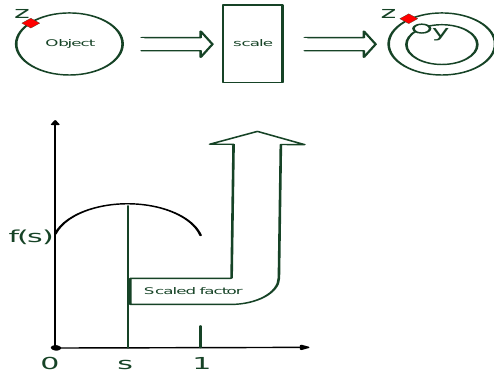
Figure 1. Random hypersurface model.